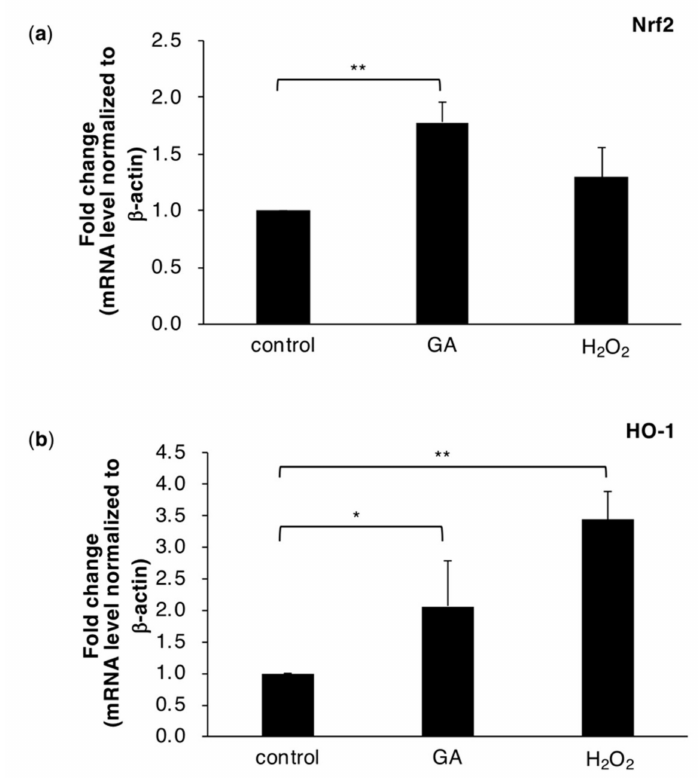
Figure 3. Quantitative real-time PCR demonstrated that Nrf2 ( a ) and HO-1 ( b ) expression levels were increased by GA in HepG2 cells after a treatment with 0 or 4 mM GA or 1 mM H 2 O 2 for 6 h. H 2 O 2 was employed as a positive control. Normalized gene expression levels were given as a ratio between the mean value for the target gene and that for β -actin in each sample. Results are mean ± S.D. * p < 0.05 and ** p < 0.01 ( n ≥ 3) based on a one-way ANOVA followed by Dunnett’s